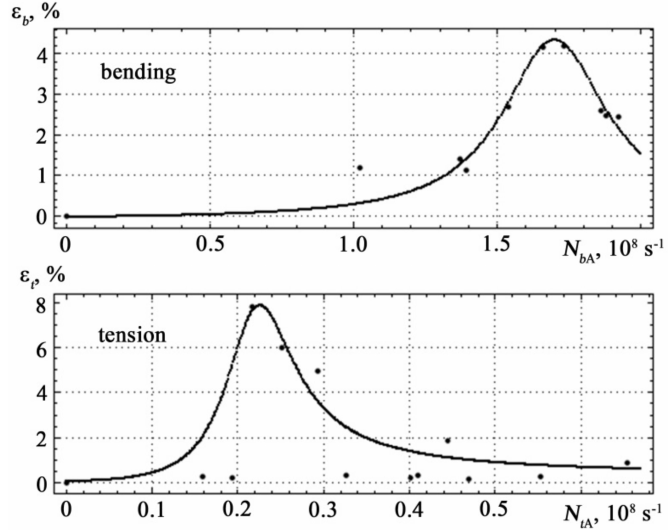
Figure 6. Dependences of the AE signal density on the relative deformation of the St3sp grade steel specimen. The dots show the experimental values, the solid line is the approximation.